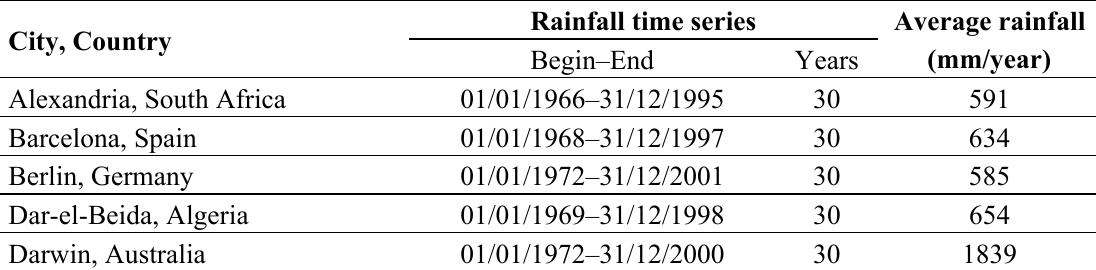
Table 2. Rainfall time series and annual average rainfall for the chosen